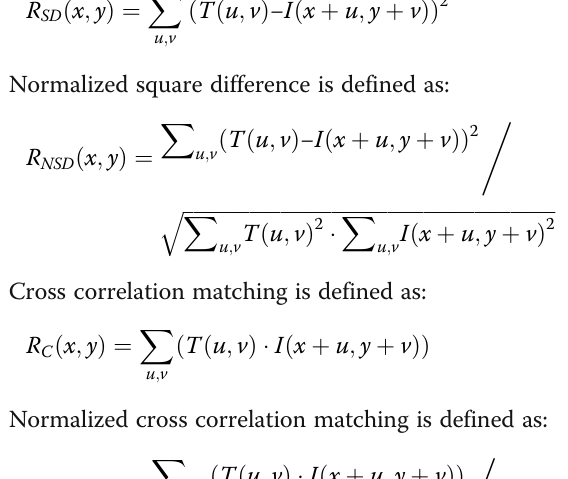
Algorithm description for 3D scoring of FISH using a confocal WSI